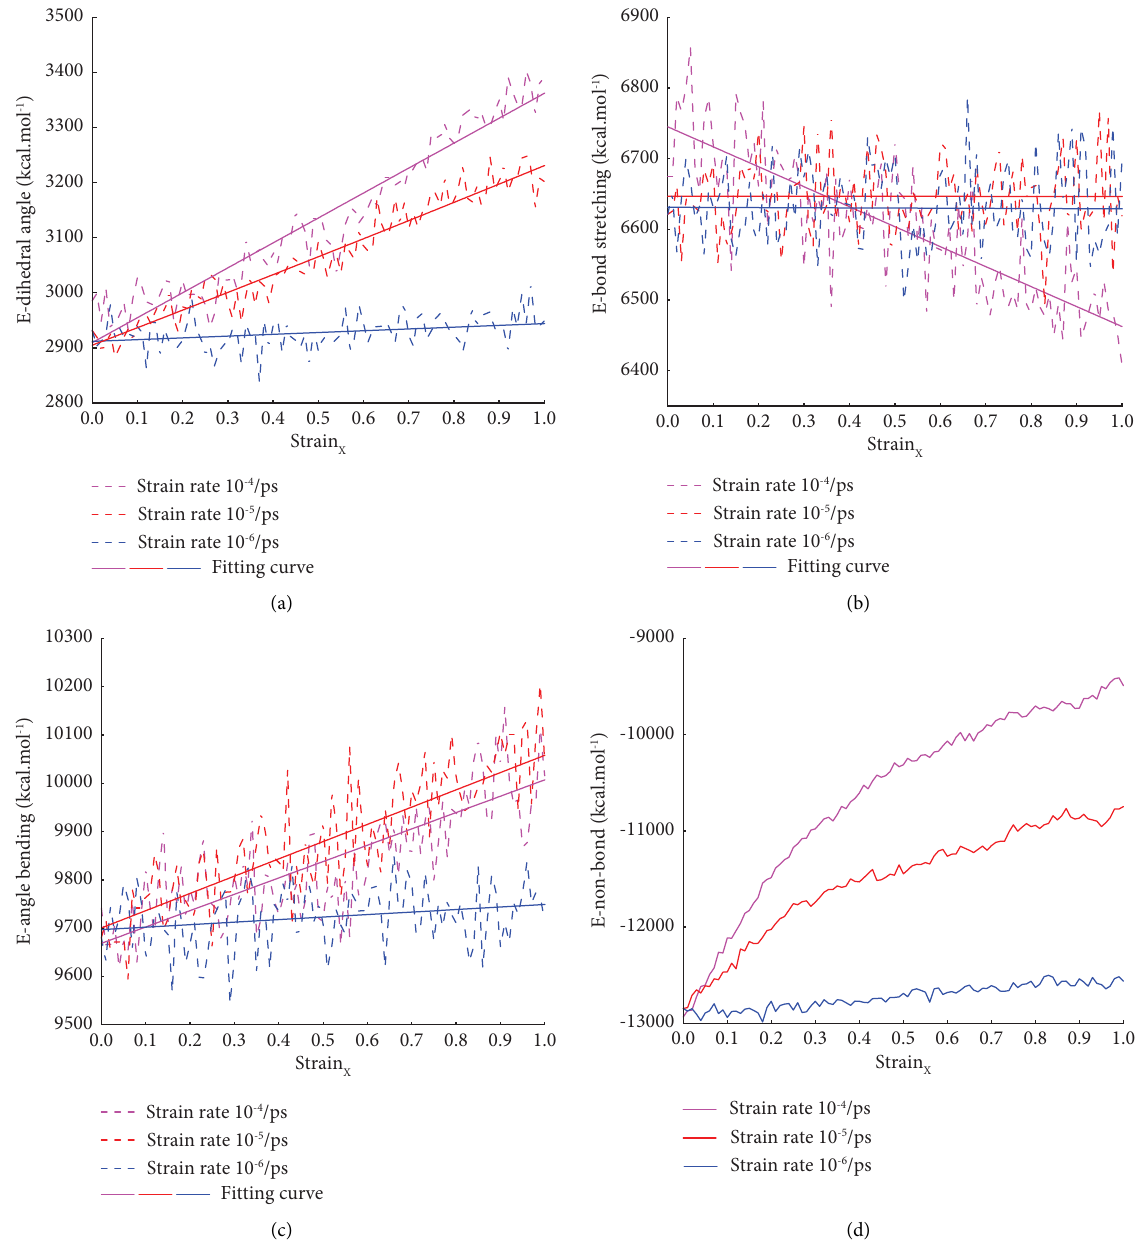
Figure 7: (a–d) Dihedral angle torsion term, bond stretching term, angle bending term, and nonbonding term change of amorphous system during the tensile processes at three strain